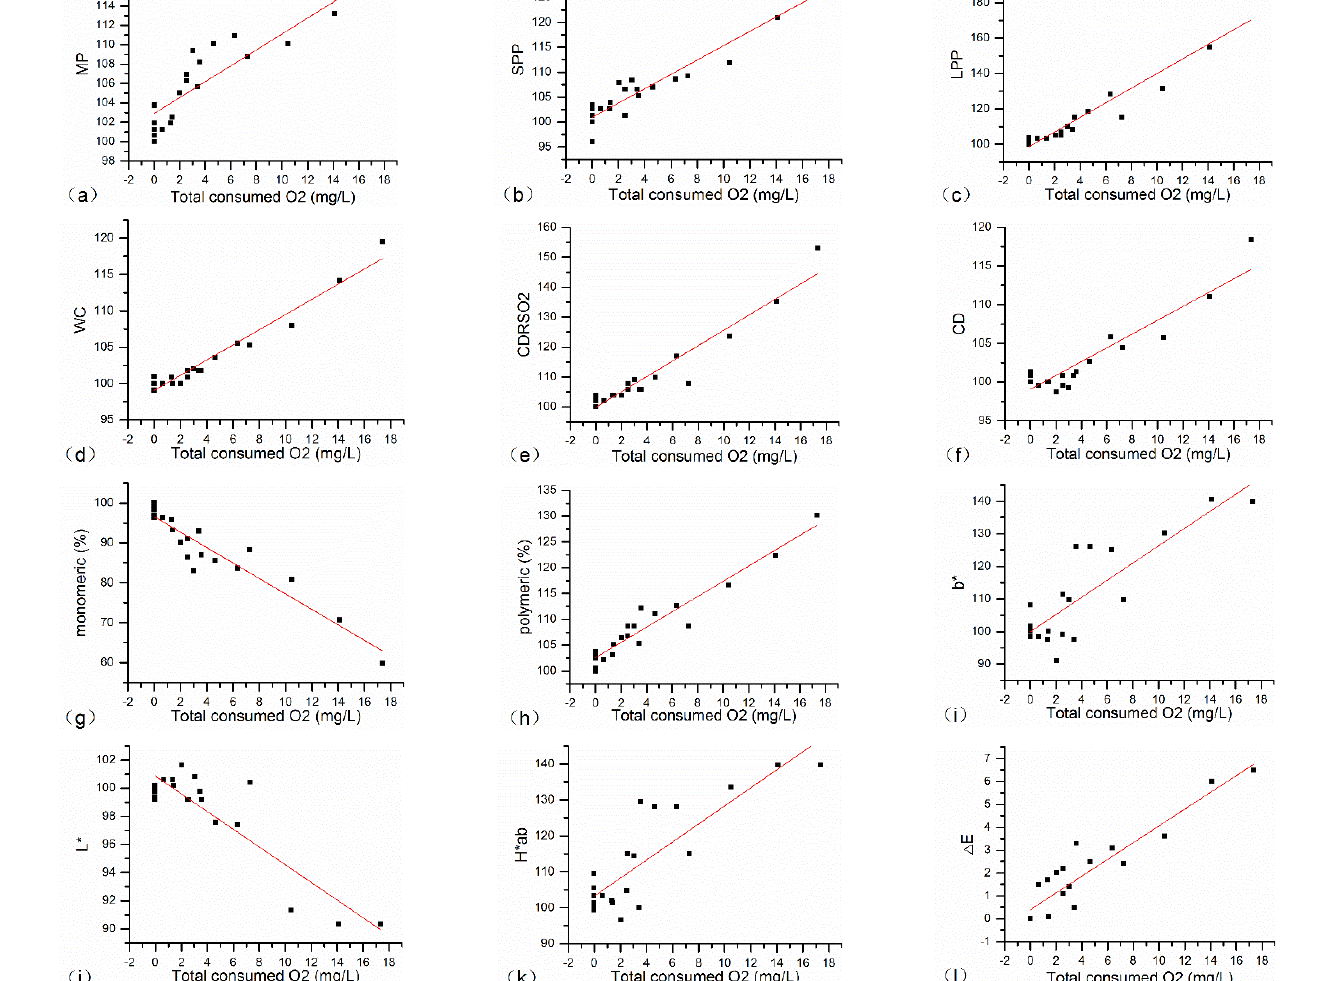
Figure 4. Plots showing the evolution with the amount of oxygen consumed of MP ( a ), SPP ( b ), LPP